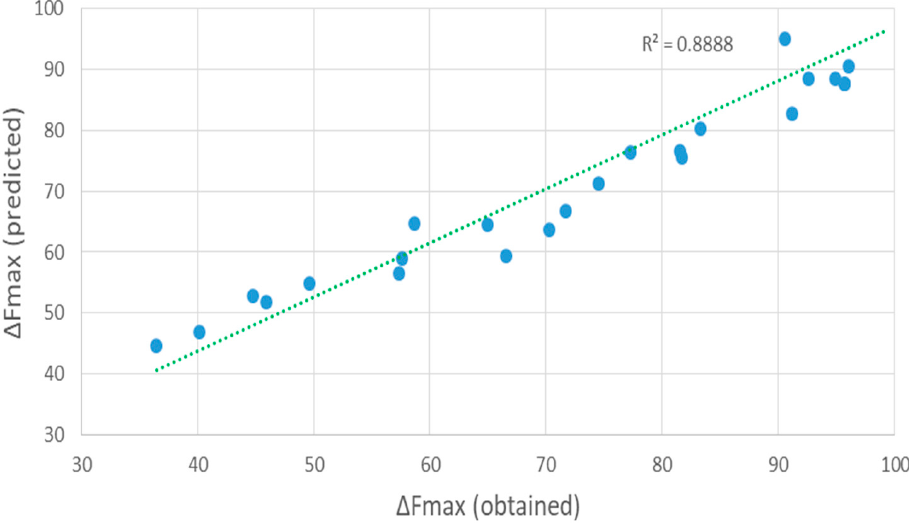
Figure 5. Predicted vs. obtained values of maximum fluidity F max .